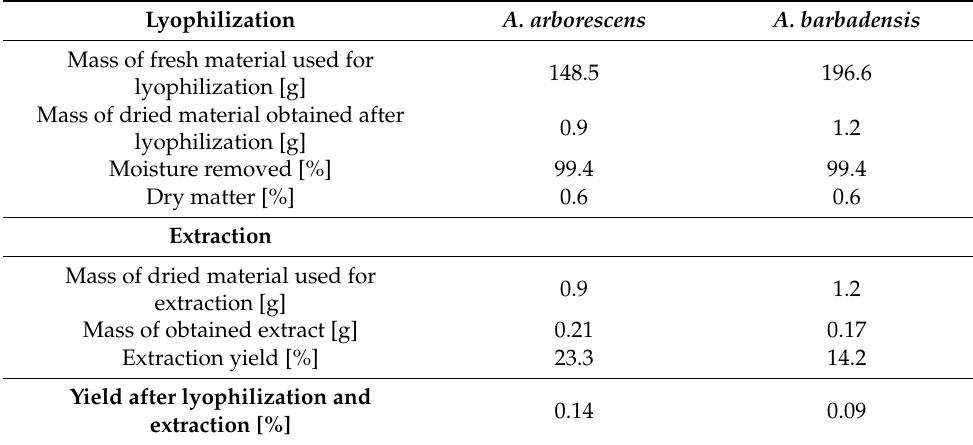
Table 1. Mass balance of the lyophilization and extraction process.